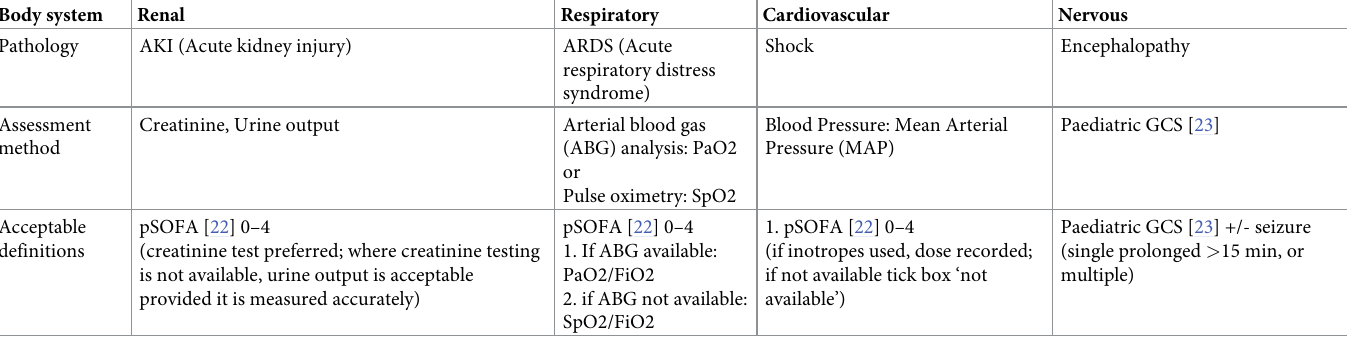
Table 3. Definition of Unfavourable Outcome